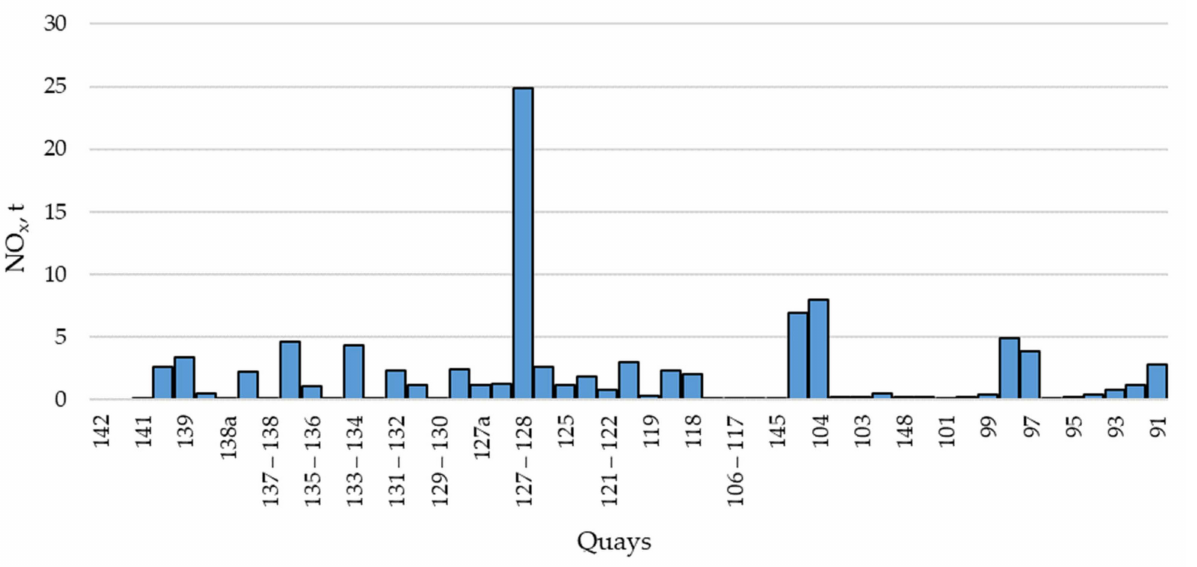
Figure 8. Distribution of emissions in port quays